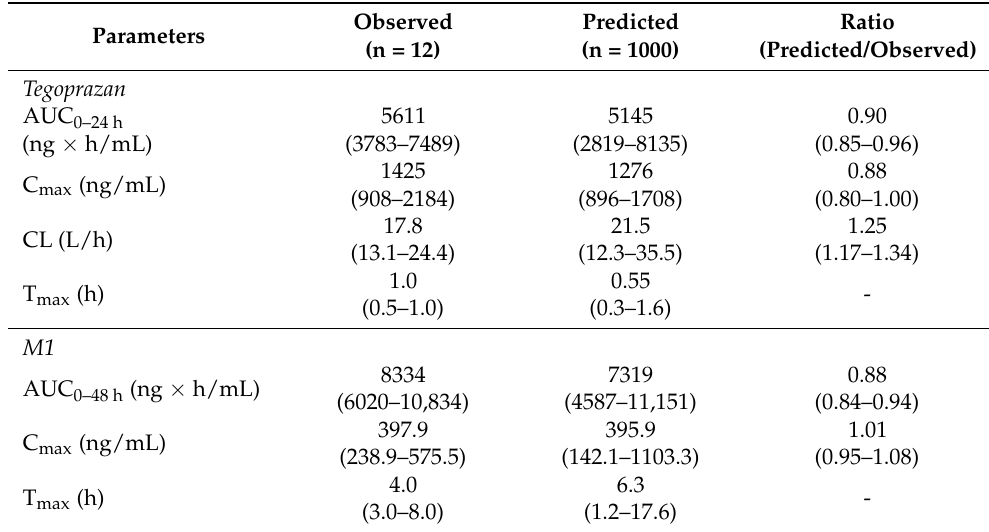
Figure 3. Observed (black dot, n = 12) and predicted (n = 1000, blue solid line) plasma ( a ) tegoprazan and ( b ) M1 concentration – time profiles after a single administration of 100 mg tegoprazan. Black dotted lines represent the predicted 95th and 5th percentiles. Table 4. The observed and predicted arithmetic mean AUC last , C max , CL values, and their ratios for tegoprazan and M1.